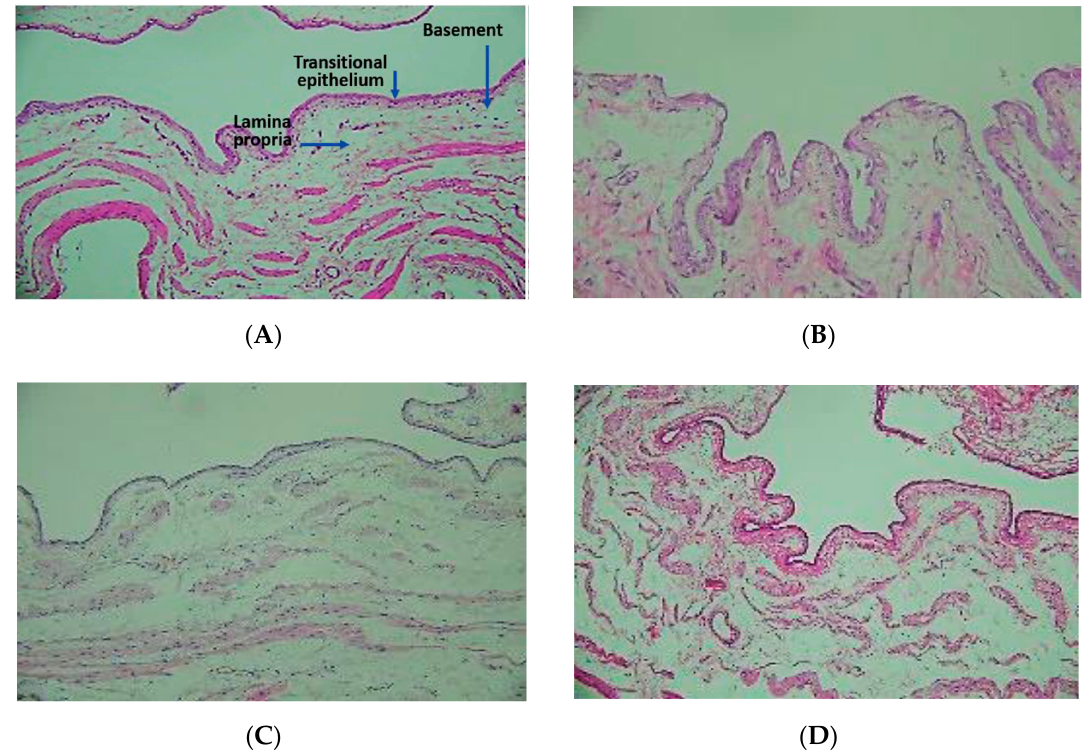
Figure 5. Histopathological images of bladder after treatment with different formulations (100×). ( A ) Untreated, ( B ) Drug solution treated, ( C ) Dual-loaded microemulsion treated and ( D ) Un-loaded microemulsion treated.